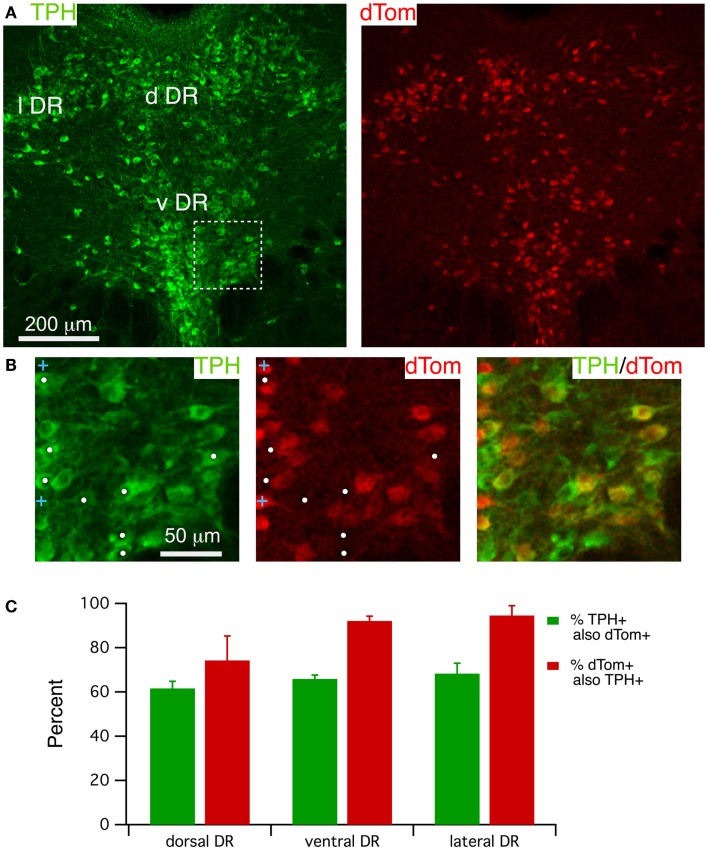
FEV-Cre mice drive dTom reporter fluorescence in most TPH+ dorsal raphe neurons. (A) A single confocal section from a Z-stack through the DR visualized with TPH immunofluorescence (488 excitation; left) and dTom reporter fluorescence (543 excitation, right). (B) Higher magnification of the boxed region in (A), visualizing label for TPH (left), dTom (middle), and both (right). White dots mark TPH+ but dTom− neurons. Blue crosses mark dTom+ but TPH− neurons. (C) Quantification of efficacy (green) and specificity (red) of dTom fluorescence in TPH+ neurons from FEV-Cre; dTom mice (n = 3). Cells were counted in fields centered on the dorsal DR (d DR), the ventral DR (v DR), and the lateral DR (l DR).